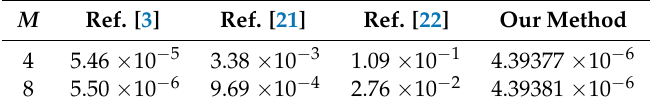
Table 1. Comparison of the maximum absolute errors (MAEs) of Problem 1 with [3,21,22] for α = 1.85. M